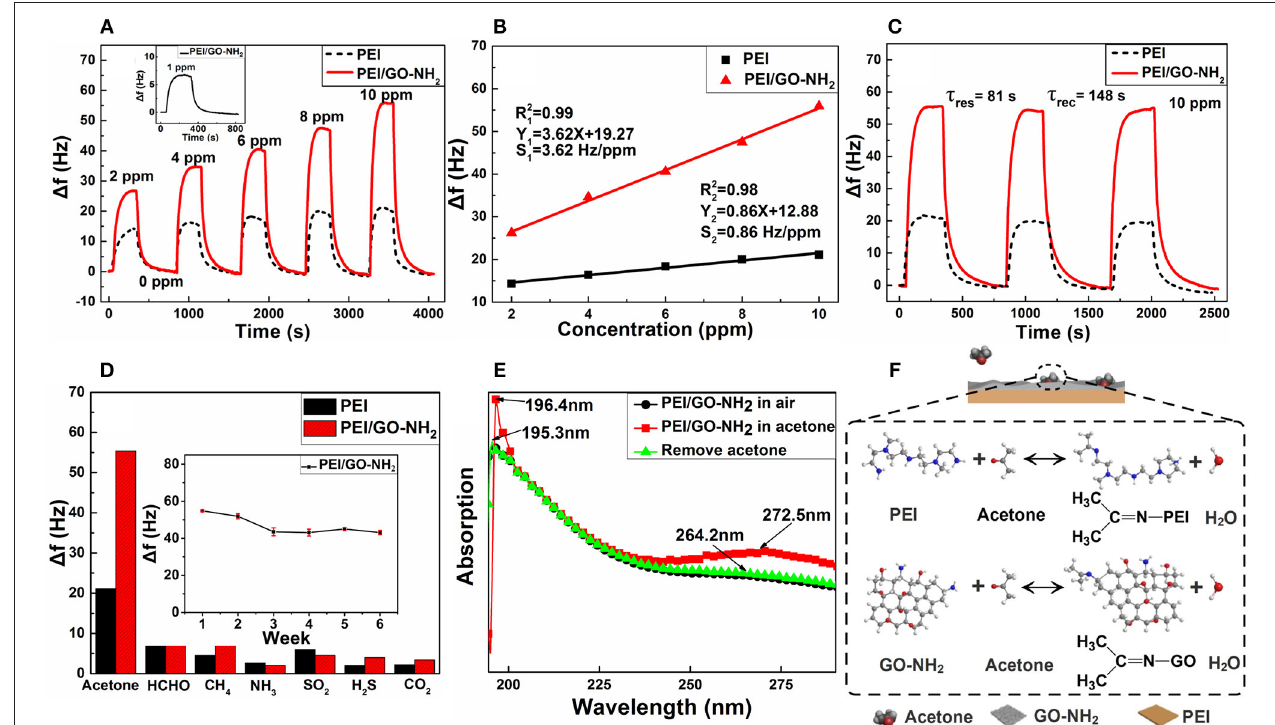
FIGURE 2 | (A) Dynamic response curves. (B) Linear fitting curves. (C) Repeatability curves and (D) selectivity of PEI and PEI/GO-NH 2 QCM sensors to acetone, the inset of (A) is the response curve of PEI/GO-NH 2 sensor for 1 ppm acetone, the inset of (D) is long-term stability curve. (E) UV-Vis spectrum of PEI/GO-NH 2 films. (F) Schematic of acetone-sensing